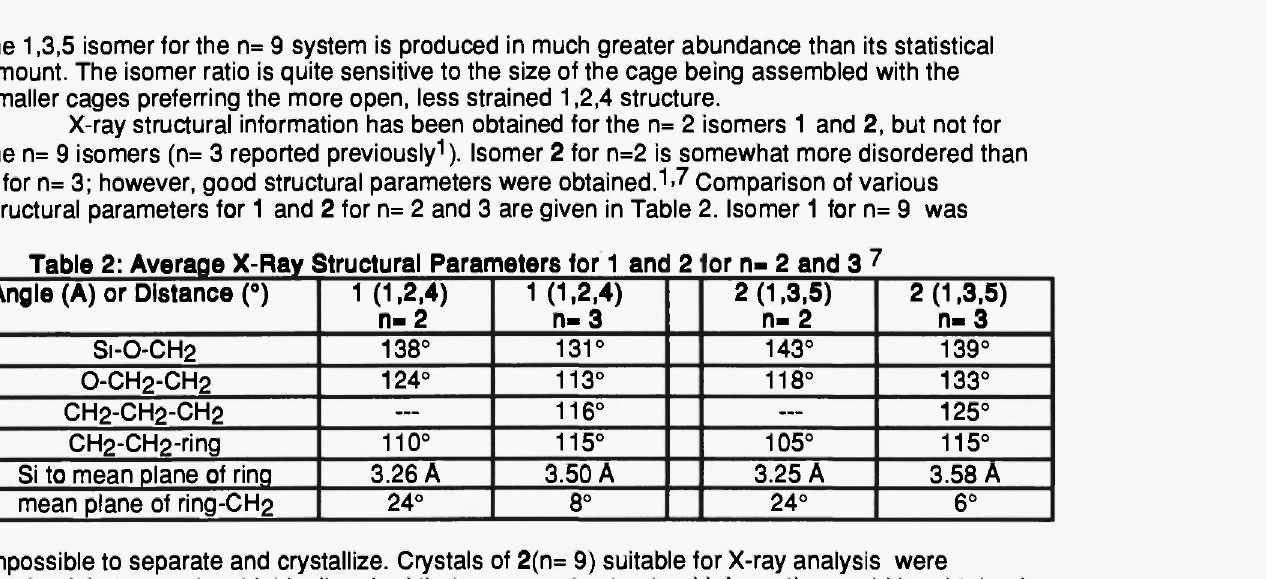
Table 2: Average X-Ray Structural Parameters for 1 and 2 or n- 2 and 3 7 Angle (A) or Distance